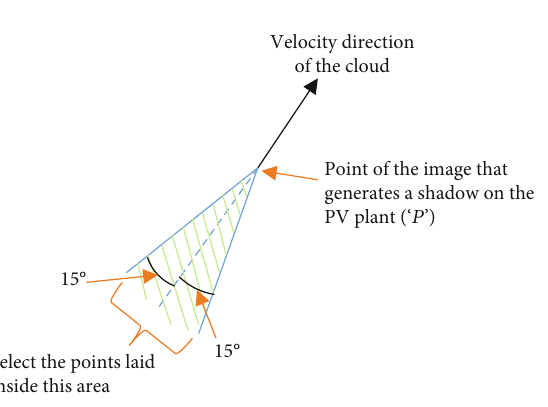
Figure 5: Cloud motion